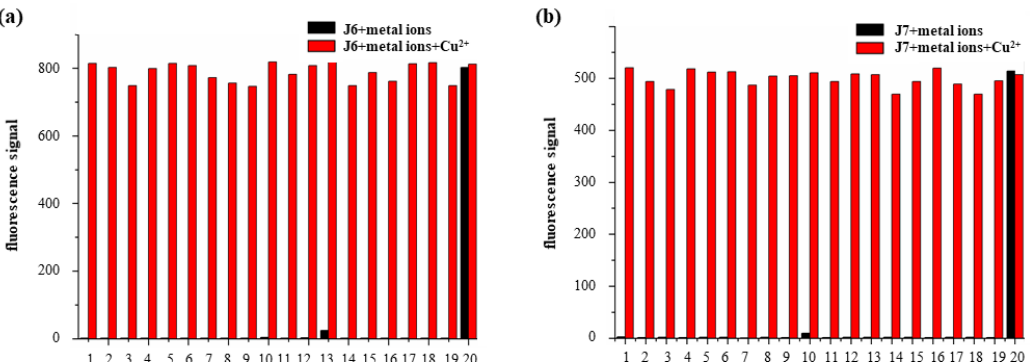
Figure 3. Selectivity of ( a ) J6 and ( b ) J7 to Cu 2+ in Cu 2+ -competing ions coexisting system with mixed solvents ( V (EtOH): V (H 2 O) = 5: 5, Tris-HCl pH = 7.4) environment. ( a ) J6: from left to right (bar 1-20): K + , Na + , Ca 2+ , Mg 2+ , Ba 2+ , Al 3+ , Ni 2+ , Pb 2+ , Mn 2+ , Cr 3+ , Co 2+ , Ag + , Fe 3+ , Zn 2+ , Cu + , Fe 2+ , Cd 2+ , Sn 2+ , Hg 2+ and Cu 2+ . ( b ) J7: from left to right (bar 1-20): K + , Na +, Ca 2+ , Mg 2+ , Ba 2+ , Al 3+ , Ni 2+ , Pb 2+ , Mn 2+ , Fe 3+ , Cr 3+ , Co 2+ , Ag + , Zn 2+ , Cu + , Fe 2+ , Cd 2+ , Sn 2+ , Hg 2+ and Cu 2+ .